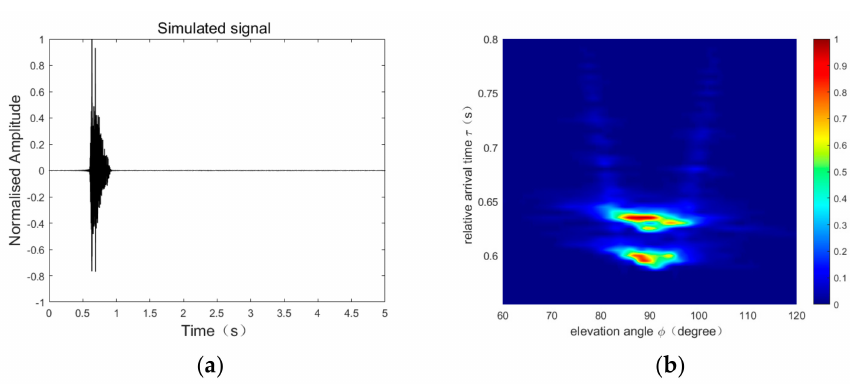
Figure 7. ( a ) Empirical waveform, ( b ) initial pulse.